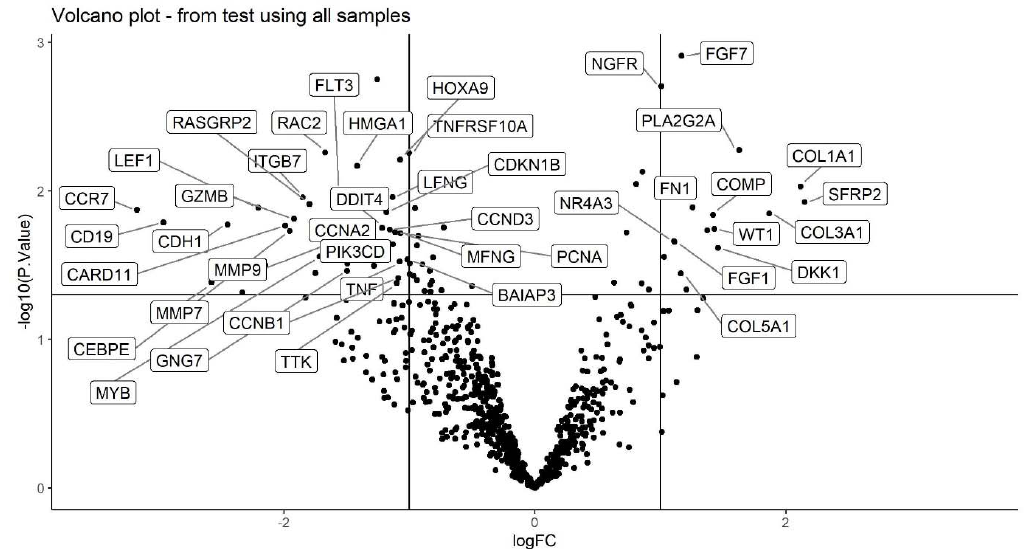
Figure 3. Volcano plot showing the log2 fold changes (Peritumour/Distant, x ‐ axis) and –log10 p ‐ values for all genes.